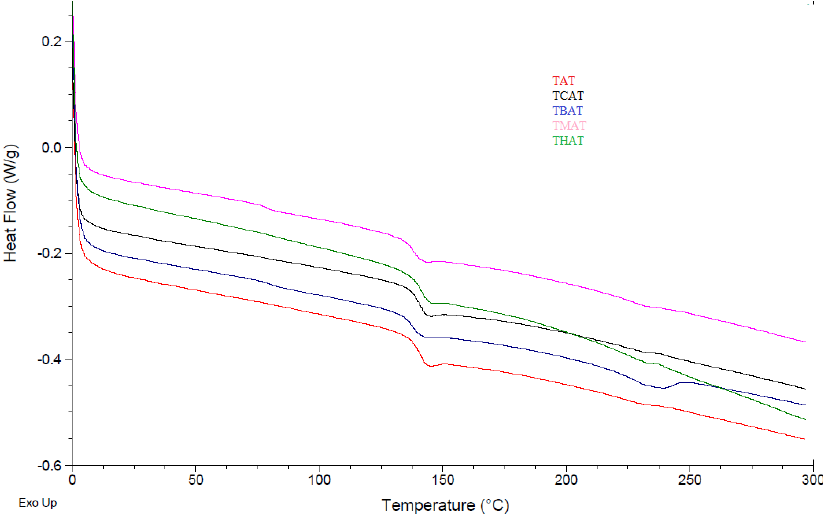
Figure 3. DSC (Differential Scanning Calorimetry) curves for sym -2,4,6-trisubstituted s -triazine derivatives (TXAT) .